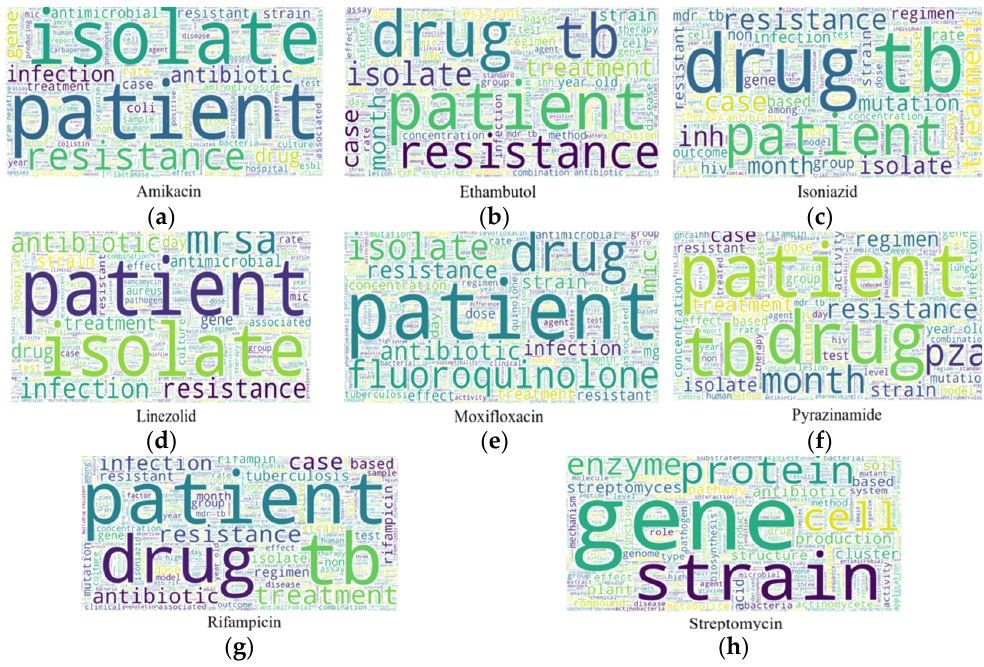
Figure 2. Word clouds for TB drugs: ( a ) Amikacin, ( b ) Ethambutol, ( c ) Isoniazid, ( d ) Linezolid, ( e ) Moxifloxacin, ( f ) Pyrazinamide, ( g ) Rifampicin, ( h ) Streptomycin .